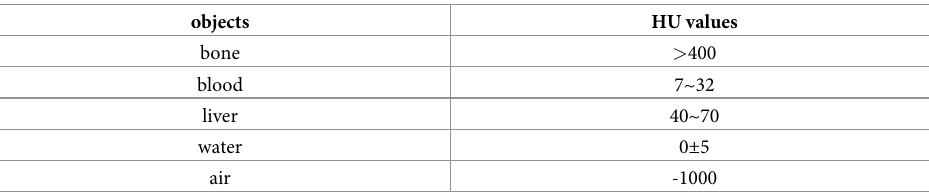
Table 1. HU values of typical objects and organs.